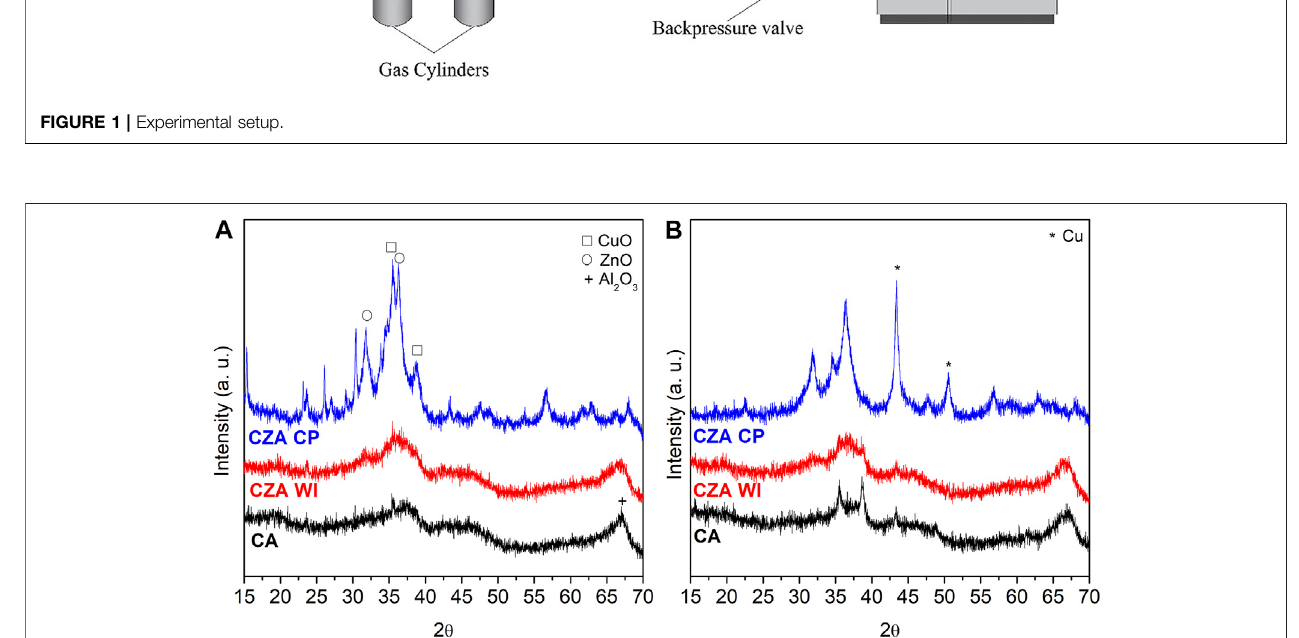
FIGURE 2 | XRD patterns of the catalysts before (A) and after (B) reactional tests.